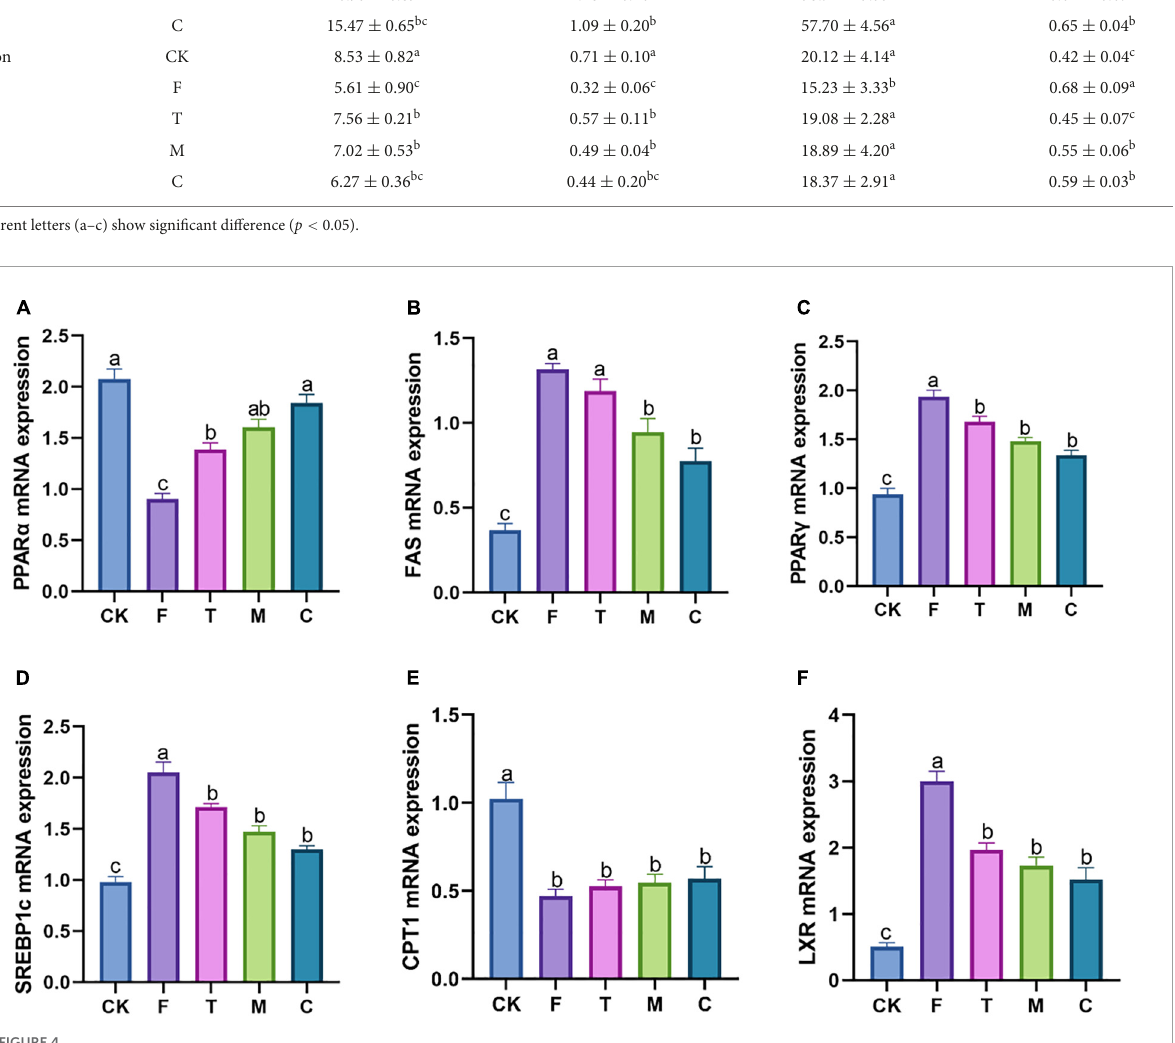
FIGURE4 Different qualities of green tea powder improved the lipid metabolism related mRNA genes expression in the high-fat diet induced obesity mice. (A) PPAR α mRNA expression levels. (B) FAS mRNA expression levels. (C) PPAR γ mRNA expression levels. (D) SREBP1c mRNA expression levels. (E) CPT-1 mRNA expression levels. (F) LXR mRNA expression levels. Different letters (a–c) showed significant difference ( p < 0.05).